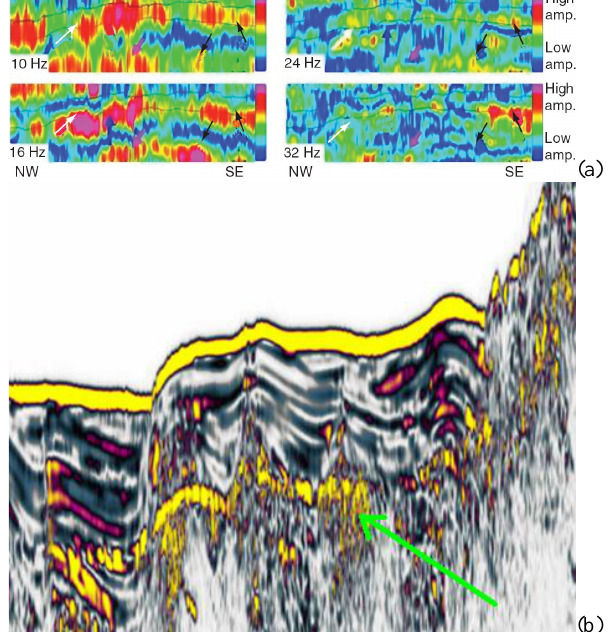
Fig. 6. The representation of results from spectral decomposition (CWT) in (a) the Sarvak formation in Iran (north of the Persian Gulf) (White, blue and black arrows represent spectral anomalies at the base of the reservoir formation (Saadatinejad and et. al., 2009) and (b) in another field in the Persian